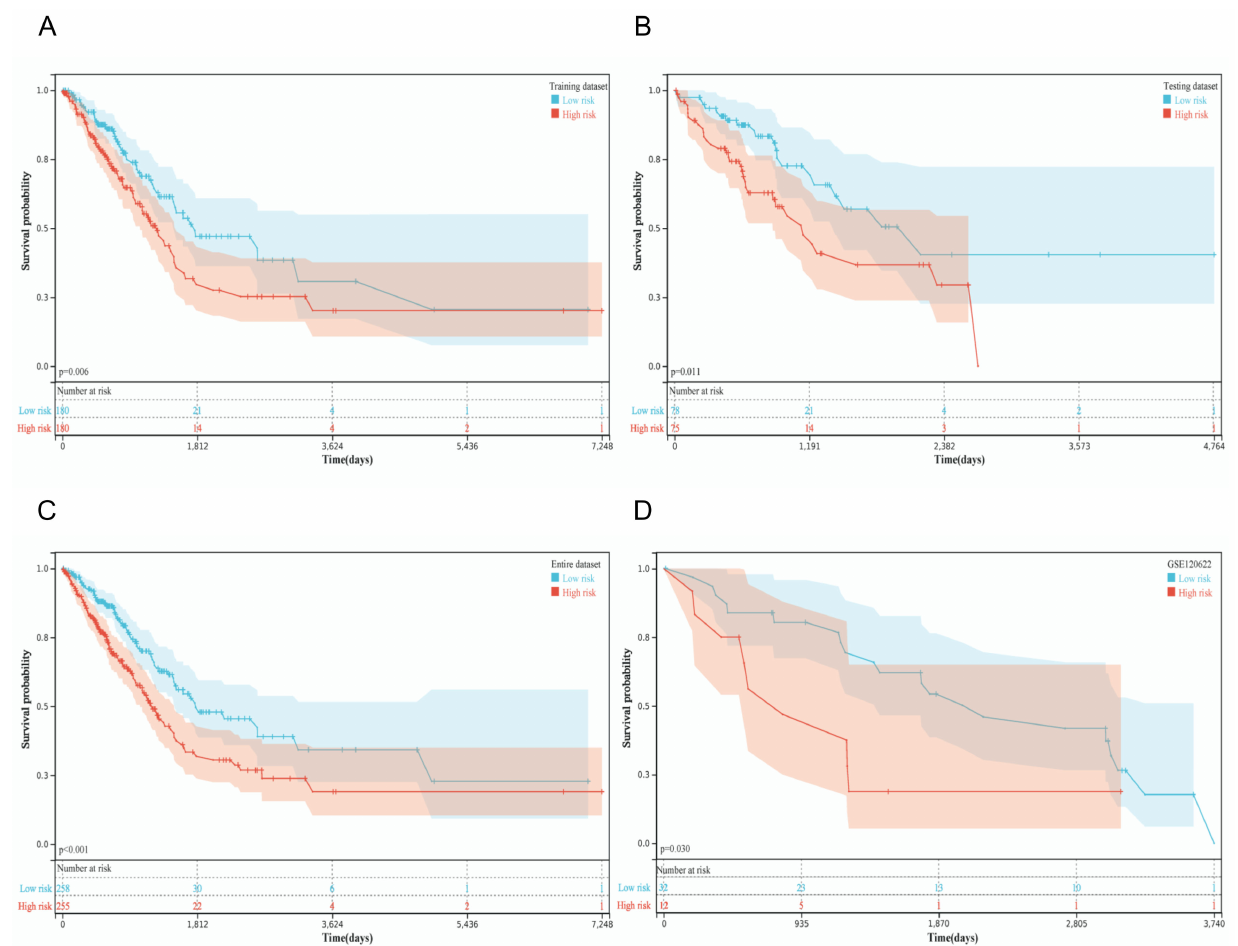
Figure 2. Survival prognosis of the risk score model. Kaplan–Meier (KM) survival curves of patients with LUAD in high- and low-risk groups from ( A ) TCGA training dataset, ( B ) TCGA testing dataset, ( C ) TCGA entire dataset, and ( D ) GSE120622. Table 1. Severity of patients with lung adenocarcinoma (LUAD) and a low-risk score vs. patients with LUAD and a high-risk score in the case-control study. Low Risk High Risk p